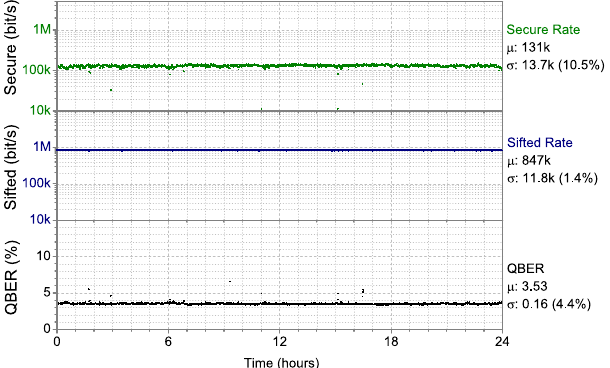
Figure 6. Field trial performance of the QKD system installed in a 45 km telecom fibre link, with general attack security. From upper to lower the secure key rate, sifted key rate and QBER are shown along with their mean